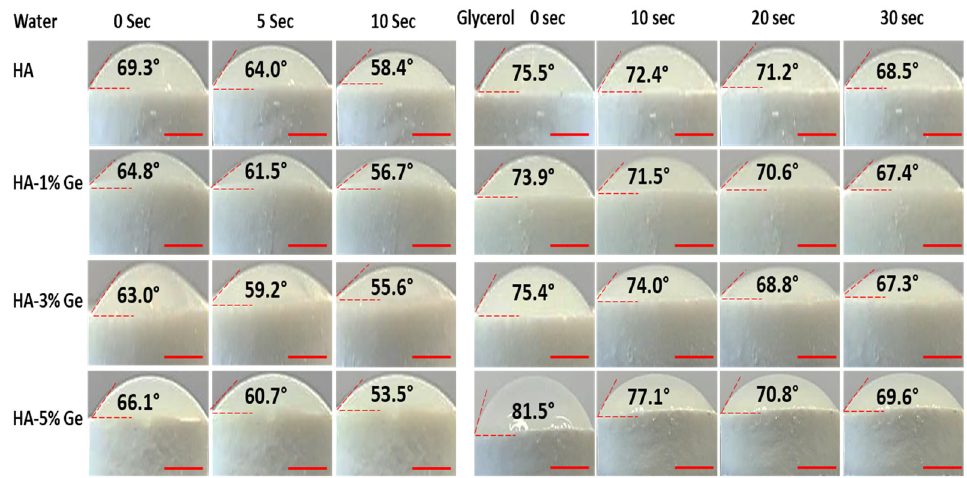
Figure 6. Contact angle behavior of HA-Ge biomaterials. Water (10 Sec) and glycerol (30 Sec) were